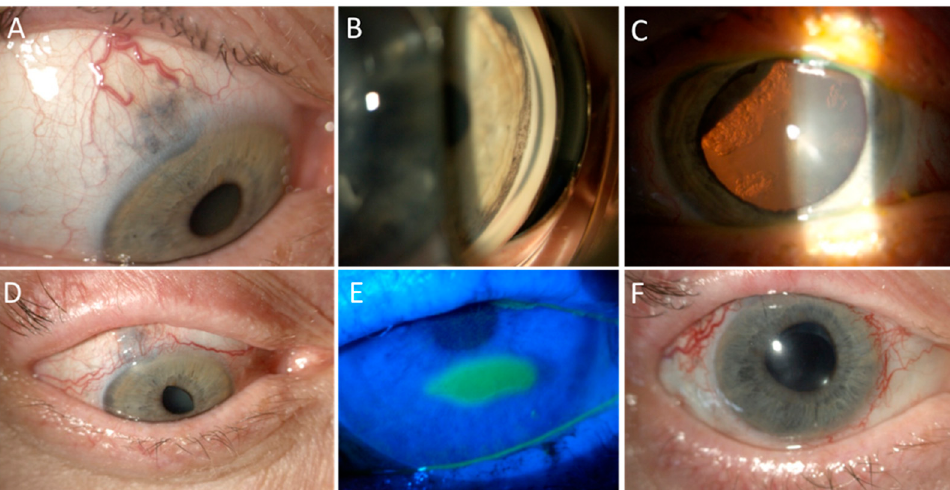
Figure 3. Anterior surface toxicity of PBR. Part ( A ): A 61 year-old lady presented with a large cilio-choroidal melanoma with scleral and iris invasion in the right eye, which was her only eye, as the left one had been previously enucleated due to a trauma. Part ( B ): Circumferential invasion of the iris angle by pigmented cells was detected on gonioscopy. Part ( C ): Sectorial cataract was present due to lens infiltration by the melanoma, as well as inferior exudative retinal detachment. The patient was treated with PBR sectorial irradiation of the ciliary body, anterior choroid, and whole iris. Harvesting of limbal stem cell was not performed due to the extraocular extension. Part ( D ): Three months after treatment, the patient developed madarosis and scarring of the superior eyelid and diffuse punctate keratitis that was managed with the regular use of artificial tears and vitamin A ointment in association with atropine and unpreserved mild steroids. Part ( E ): Eight months after treatment, a neurotrophic keratopathy developed and was treated with gas-permeable contact lenses and hourly tear substitutes. Part ( F ): Two years after PBR, the tumour has regressed to a flat scar. The patient has undergone cataract surgery and anti-vascular endothelial growth factor injections, vitrectomy, and endolaser for neovascular glaucoma due to ischemic retinopathy, with a residual visual acuity of 20/200 due to radiation